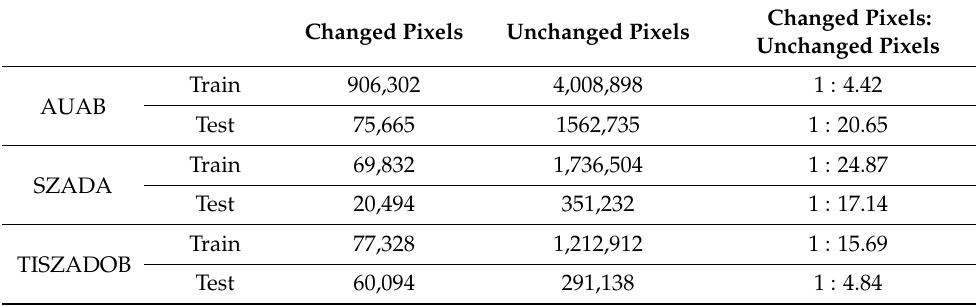
Table 2. The number of changed and unchanged pixels on the AUAB dataset and the SZTAKI dataset. Changed Pixels Unchanged Pixels